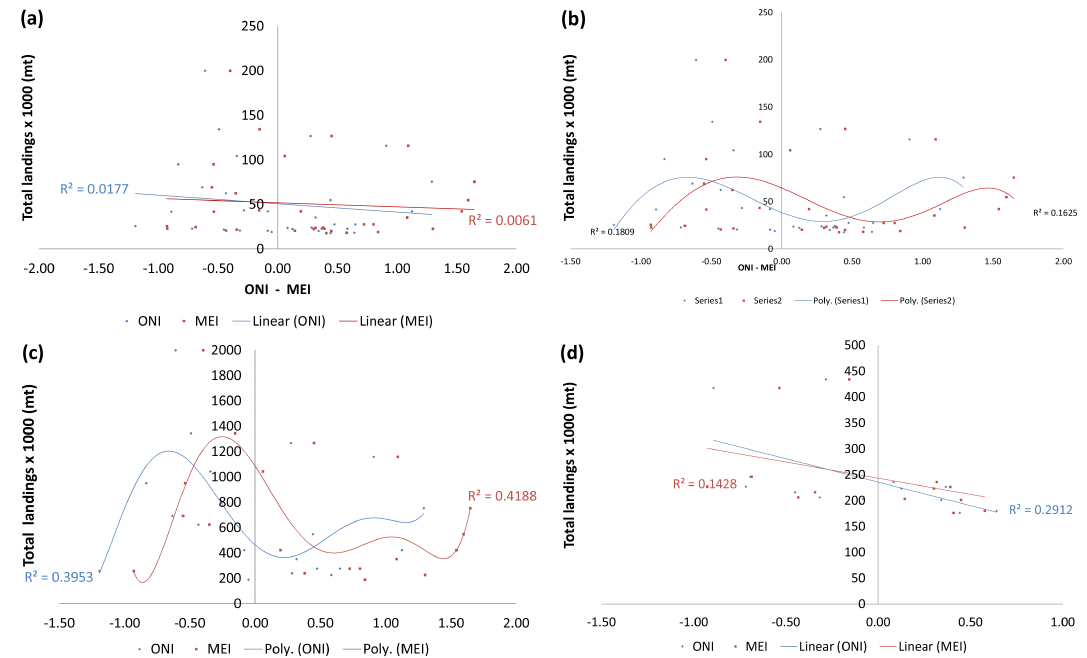
Figure 3. Total landings vs. the ONI and MEI for periods (a) 1981–2012, (b) 1981–2012, n = 5, (c) 1981–1999, n = 6, and (d)